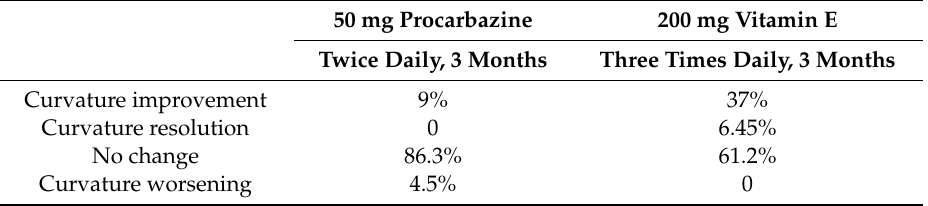
Table 11. Procarbazine vs. Vitamin E: Randomized, Crossover